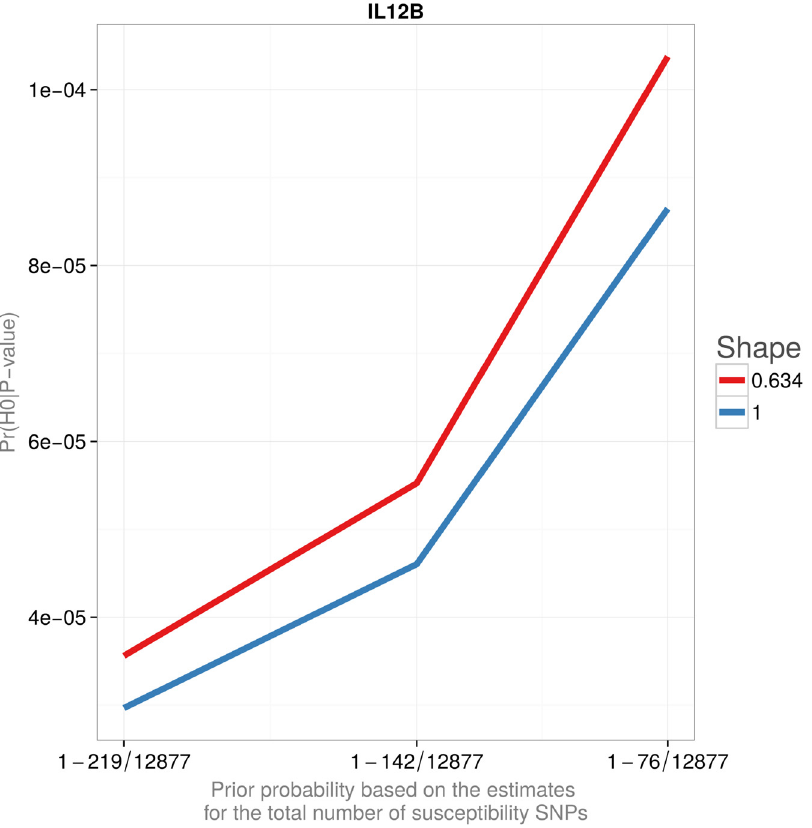
Fig 3. Minus log of posterior probabilities that the finding is spurious. Minus 1-POFIG for novel SNP associations with Crohn ’ s disease in Barrett et al. reported on the logarithmic